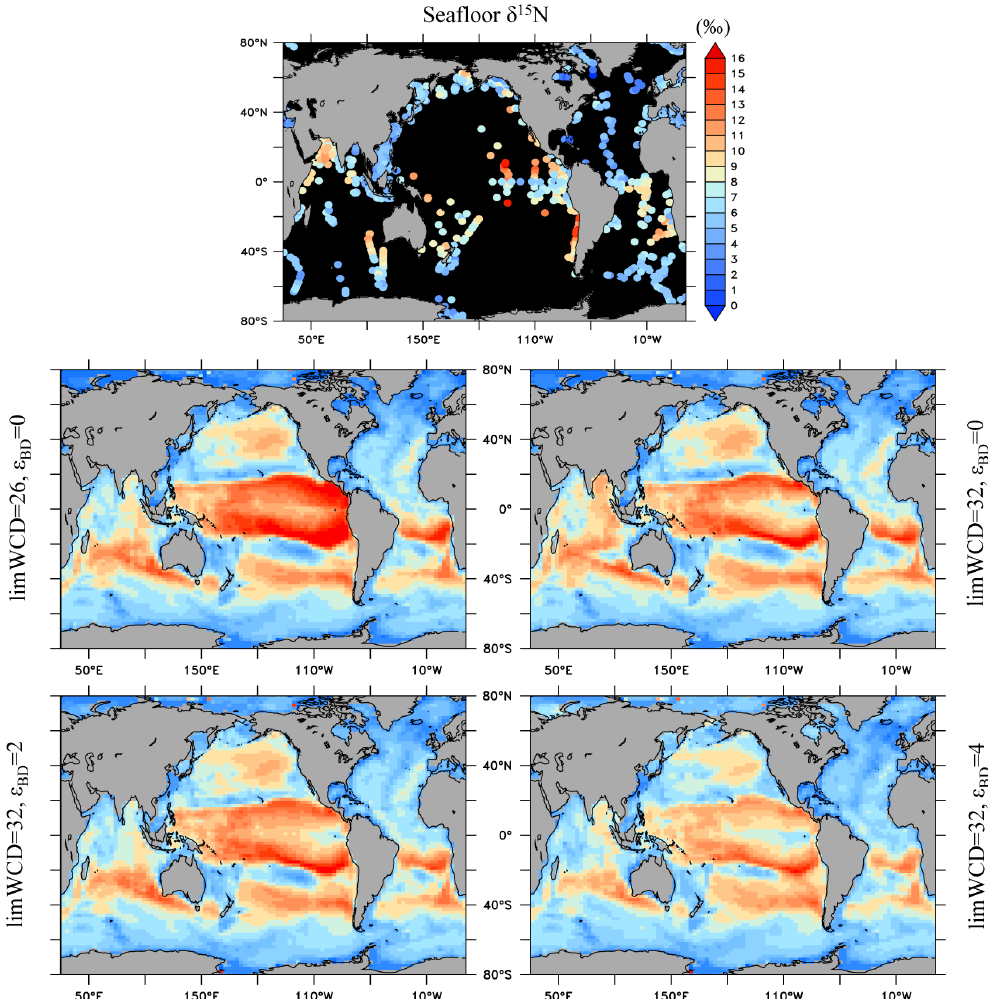
Fig. 3. Seafloor δ 15 N (Tesdal et al., 2012) comparison with model seafloor δ 15 N with limWCD = 26, ε BD = 0; and limWCD = 32, ε BD = 0, 2, and 4‰ for all experiments shown here. Note a simple diagenetic model was applied to model sinking δ 15 N to account for diagenetic alteration during burial into the seafloor sediments based on seafloor depth (Robinson et al., 2012). See text for additional